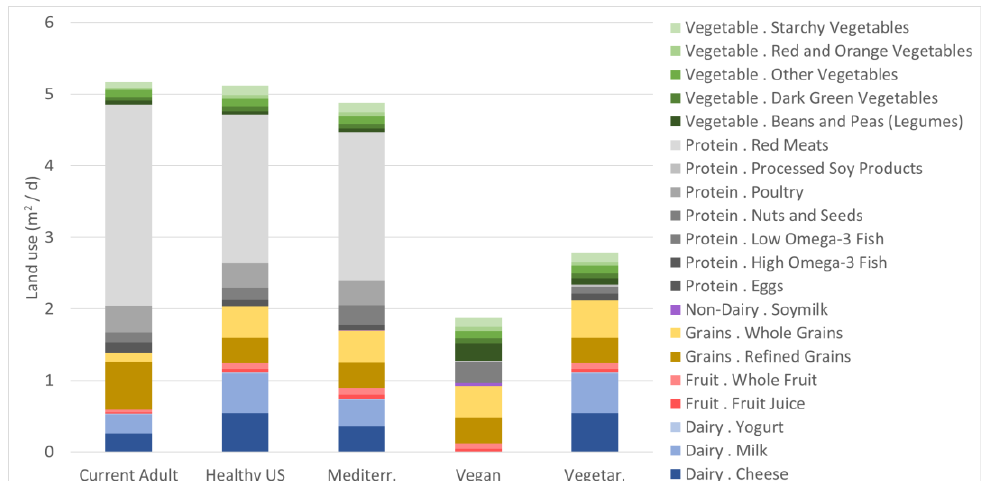
Figure 1. On-farm land use requirements for five diets reflecting an average of 2000 kcalories (recommended diets) or 2155 calories (Current diet), with major food group (dairy, fruit, grains, non-dairy, protein, and vegetable) and subgroups indicated by column colors.